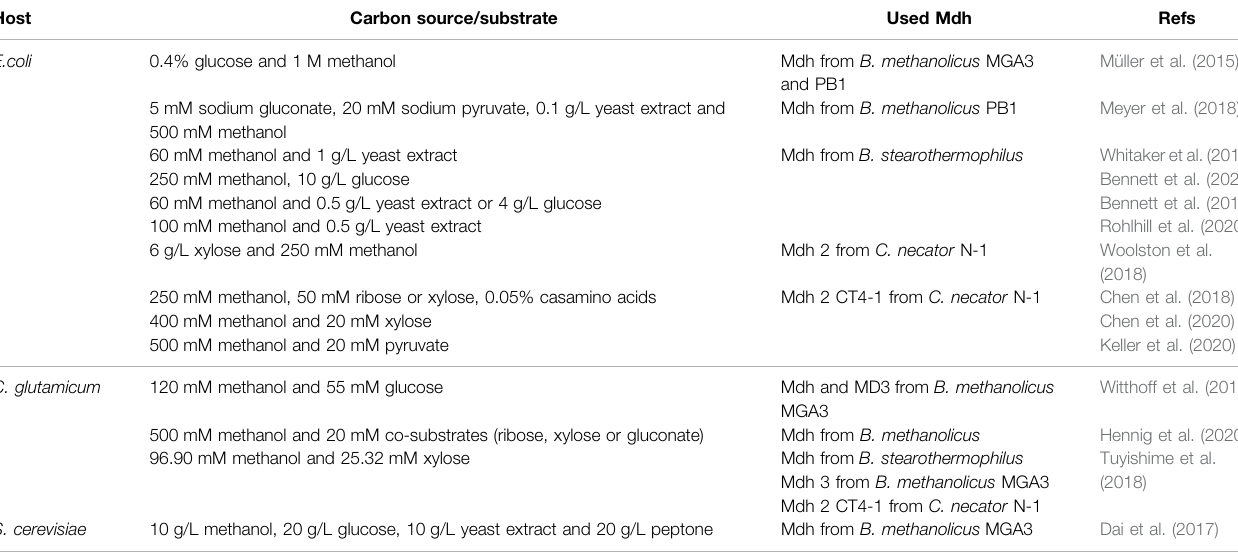
TABLE 3 | Strategies and advancements in improving methanol bioconversion ef fi ciency of synthetic methylotrophy in recent literature.